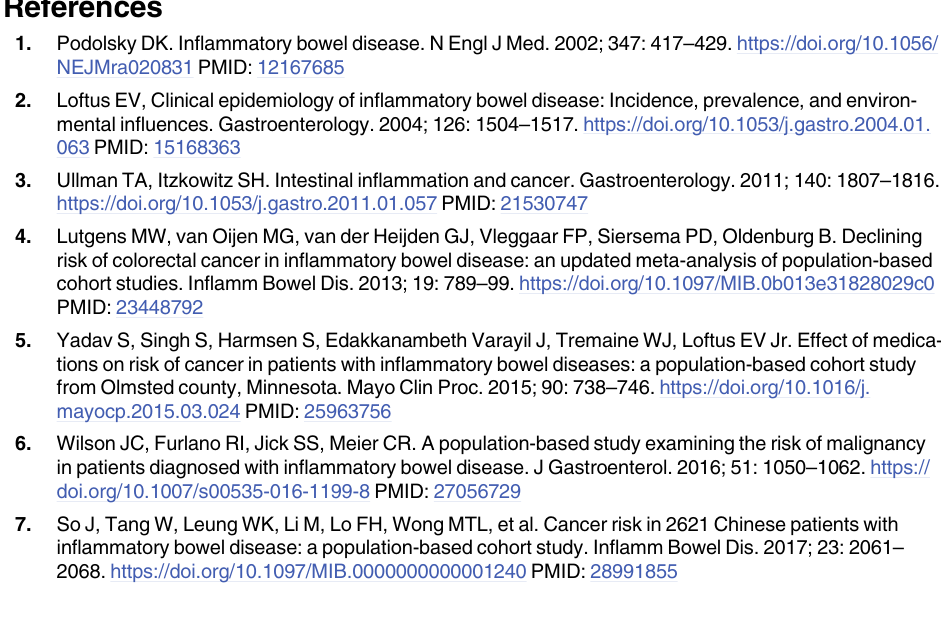
S1 Table. Standardized Incidence Ratios (SIR) with corresponding 95% Confidence Inter- vals (CI) in patients with Inflammatory Bowel Disease (IBD) for selected cancer sites, according to time since IBD diagnosis ( < 1, 1–3, > 3 years) and IBD type. Friuli Venezia Giulia, northeastern Italy,